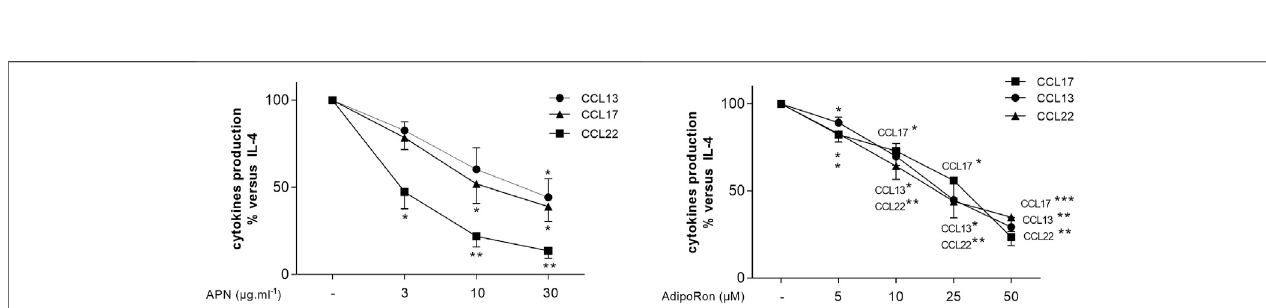
FIGURE 7 | Inhibitory effects of APN and AdipoRon on the IL-4-induced chemokine release by human LMs. Macrophages were incubated in the absence or presenceofAPN(3,10or30 µg ml − 1 )orAdipoRon(5,10,25or50 µM)beforebeingstimulatedwithIL-4(10 ng ml − 1 )for24 h.Dataareexpressedasapercentagewith respect toIL-4-induced production. Results areshown asthemean ± SEMof6 – 12differentexperiments. Asterisks indicate signi fi canteffects withrespecttoIL-4alone (*: p < 0.05; **: p < 0.01; ***: p < 0.001).